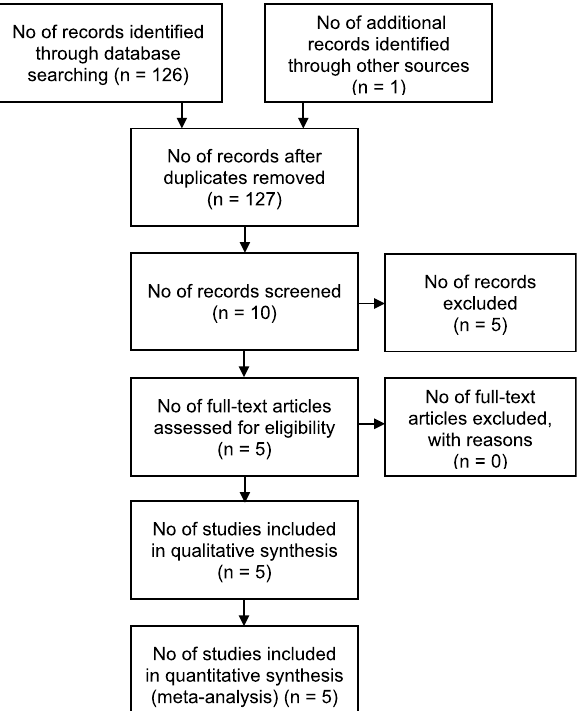
Figure 1. PRISMA-scheme of the systematic literature review. Presented is the PRISMA-scheme of the systematic literature review, inspired by Moher et al. 11